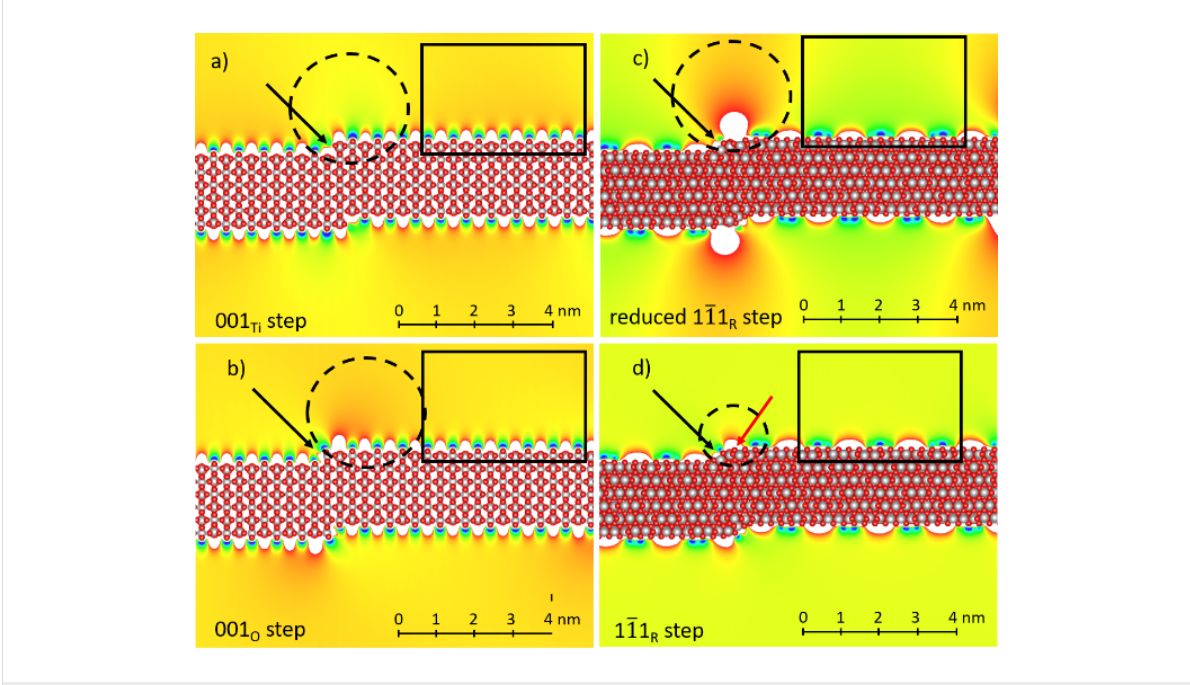
Figure 5: DFT simulation of the local electrostatic potential for the a) , b) , c) reduced , and d) steps. Black arrows show the position of the step, the dashed ellipse and rectangle highlight the step and the (110) terrace, respectively. The red arrow in d) indicates the closest bridging oxygen atom that was removed in c) to produce the reduced step configuration. Please note that the local potential inside the black rectangle does not have the same values because of different areas and geometries were considered for the different step configurations. The color code has the same absolute scale across all step configurations. Red indicates smaller CPD values, while blue indicates larger CPD values.